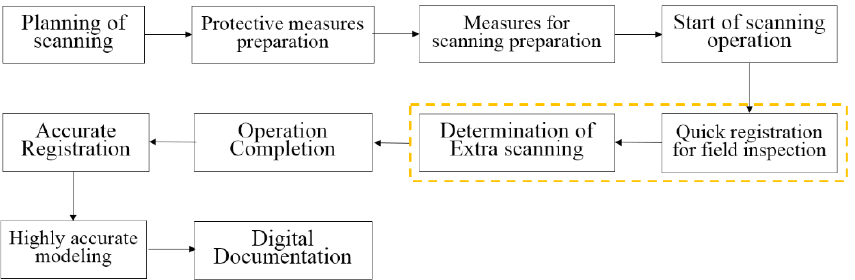
Figure 1. Processingpipelineofdigitaldocumentation(orangeboxshowstheresearchcontentofthisarticle).